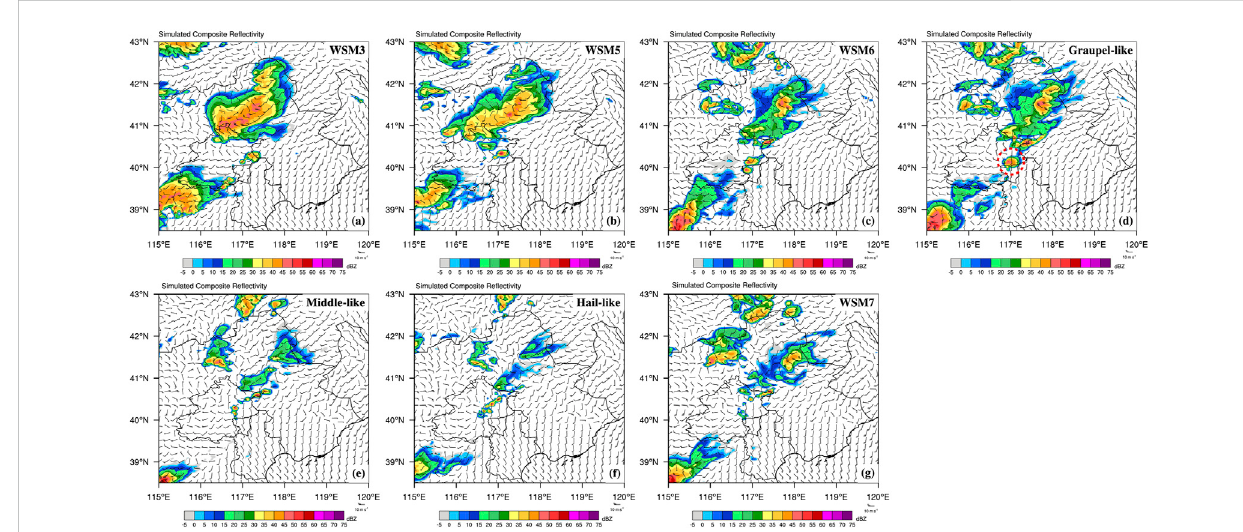
FIGURE 5 Simulatedcompositeradarre fl ectivity(shaded;dBZ)superimposedhorizontalwind fi eldsat10 m(vector;ms − 1 )attimeofconvectiveinitiationforall seven experiments: (A) WSM3, (B) WSM5, (C) WSM6, (D) WSM6-Graupel-Like, (E) WSM6-Middle-Like, (F) WSM6-Hail-Like and (G) WSM7 experiments. The red circle marker in (D) denotes the location where convective initiated at fi rst; and the statistical times of convection initiation for each experiment are shown in Table 2.